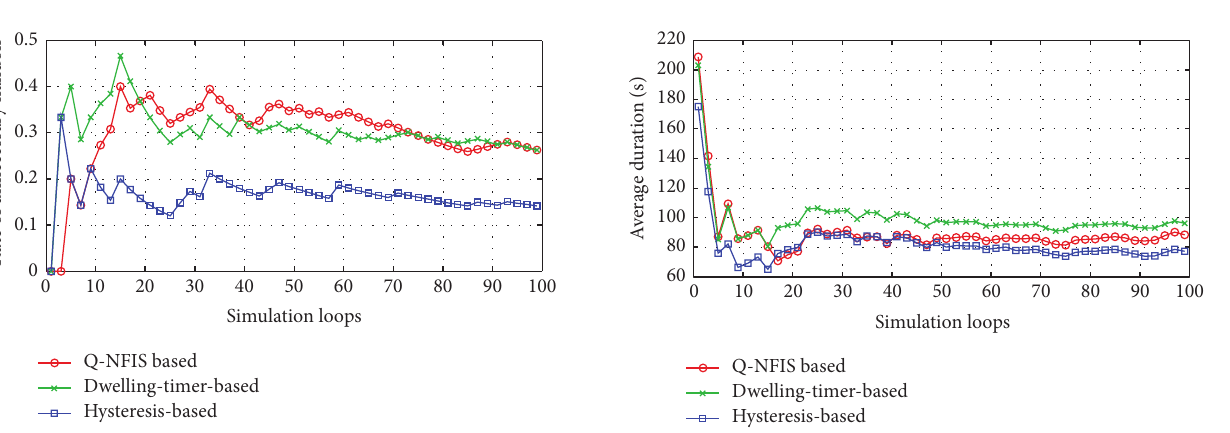
Figure 4: Comparison of unnecessary handoff rate for 3 algorithms in first 100 simulation loops.